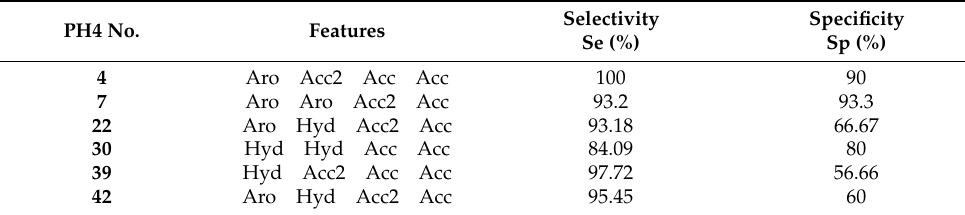
Table 1. The selectivity and specificity of the best performing pharmacophore for active site SHP2 inhibitors. PH4 No.